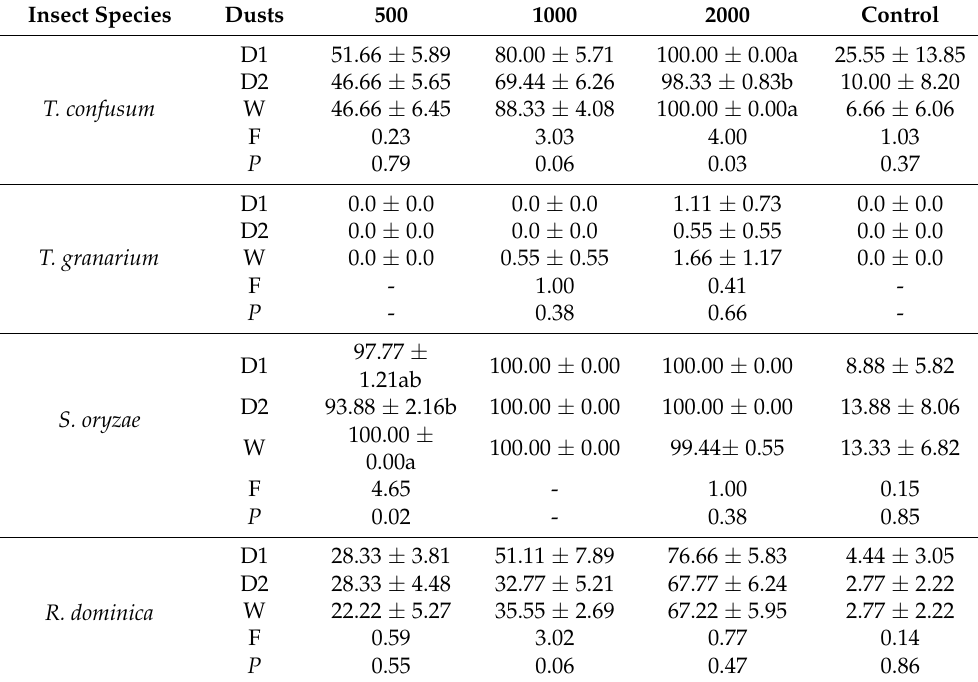
Table 6. Mean mortality (% ± SE) of Tribolium confusum , Sitophilus oryzae , Rhyzopertha dominica adults and Trogoderma granarium larvae after exposure to three different dust formulations (D1, D2, and W) applied at four concentration rates (500, 1000, 2000 ppm, and control) for Day 14 (in all cases df =